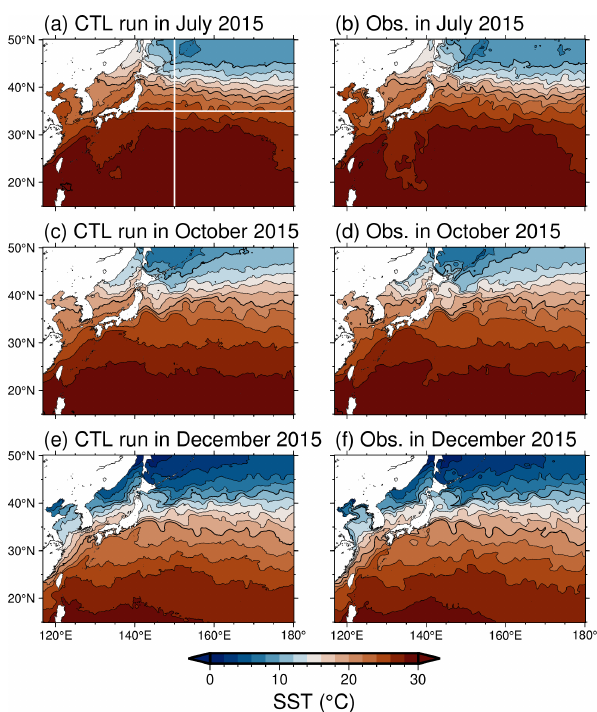
Figure 1. Monthly mean SSTs for (a) July, (c) October, and (e) De- cember 2015 in the CTL run. Panels (b) , (d) , and (f) are the same as panels (a) , (c) , and (e) , respectively, but for assimilated satellite SSTs. Thin (thick) black contour intervals are 2 (10) ◦ C. The white lines in panel (a) indicate 150 ◦ E (35 ◦ N) used for the zonal (merid- ional) sections in Fig.